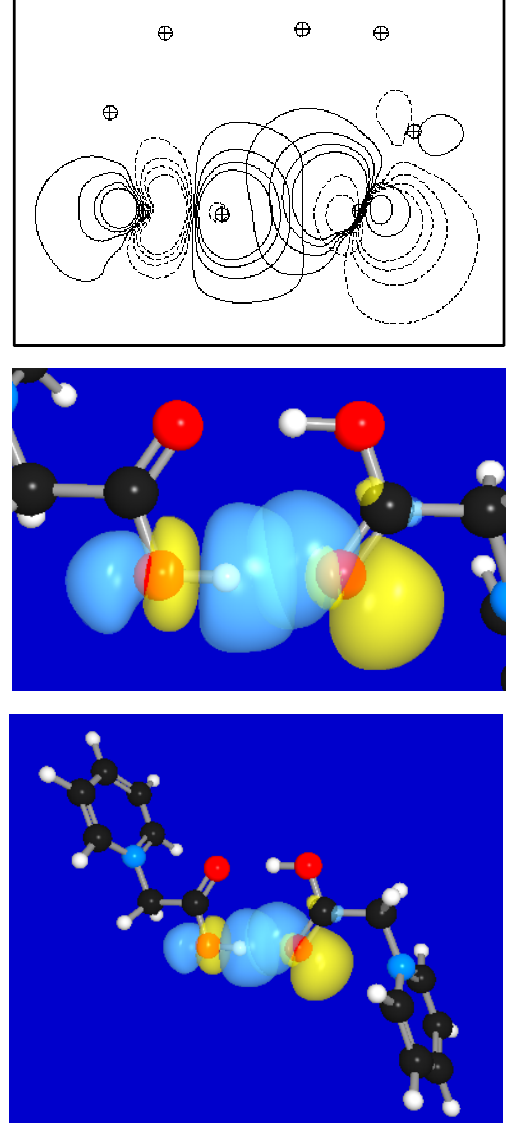
Figure 10. NBO 2D contour and 3D overlap diagrams for n O → σ * OH donor–acceptor interaction in the cationic dimer (HCOO–CH 2 –py + ) 2 equilibrium geometry with estimated second-order Δ E (2)n → σ * = 27.5 kcal·mol − 1 interaction.